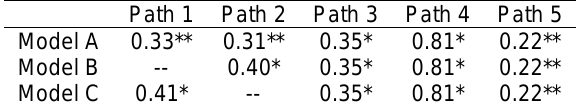
Table 2. Path analysis coefficients